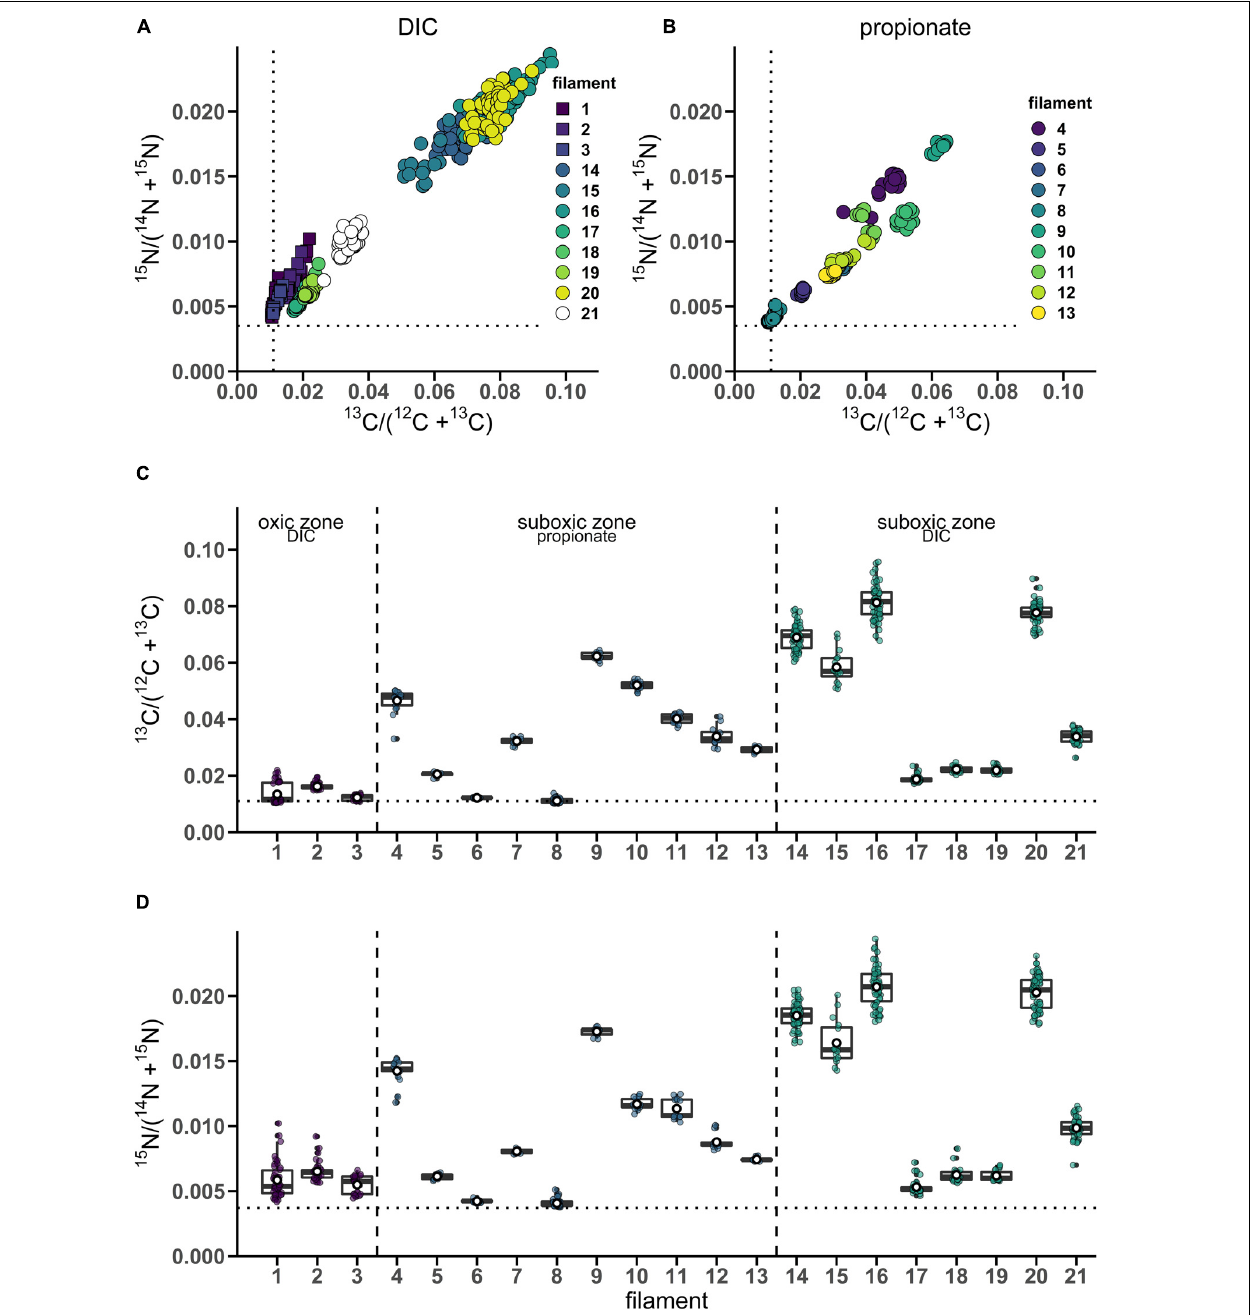
FIGURE 1 | Variation of isotope label uptake among cells in individual cable bacteria as measured by nanoSIMS. Cross-plots show the correlation between the average 13 C and 15 N atom fractions per cell. Shown are atom fractions from 24 h-labeling with (A) 13 C-bicarbonate and 15 N-ammonia and (B) 13 C-propionate and 15 N-ammonia. Each data point represents the mean 13 C and 15 N atom fraction for a cell measured in the followed filaments. Colors and symbols differentiate between individual filaments and redox zones in the sediment from which the filaments were retrieved, respectively. Boxplots show the average (C) 13 C or (D) 15 N atom fraction in individual cells (data points) and the corresponding mean (white open dot), median (black line) and upper and lower quartiles for each individual filament. n = 21 filaments have been analyzed in total. Individual filaments were retrieved from the oxic zone of the incubation with 13 C-labeled bicarbonate ( n = 3), from the suboxic zone of the incubation with 13 C-labeled propionate ( n = 10) and from the suboxic zone of the incubation with 13 C-labeled bicarbonate ( n = 8). Dotted lines represent the natural 13 C (0.011) and 15 N (0.0037) atom fractions. The clustering of data points shows that intra-filament variation is substantially smaller than inter-filament variation. The filaments from the suboxic zone incubation with 13 C-labeled bicarbonate (14–21) were also analyzed by Geerlings et al. (2020). The corresponding nanoSIMS images of the 13 C atom fractions from each filament are given in Supplementary Figure 1 (filaments #1–19 and #21) or in Figure 5 (filament #20). The values of the 13 C and 15 N atom fractions for each of the cells can be found in Supplementary Datasheet 1 .